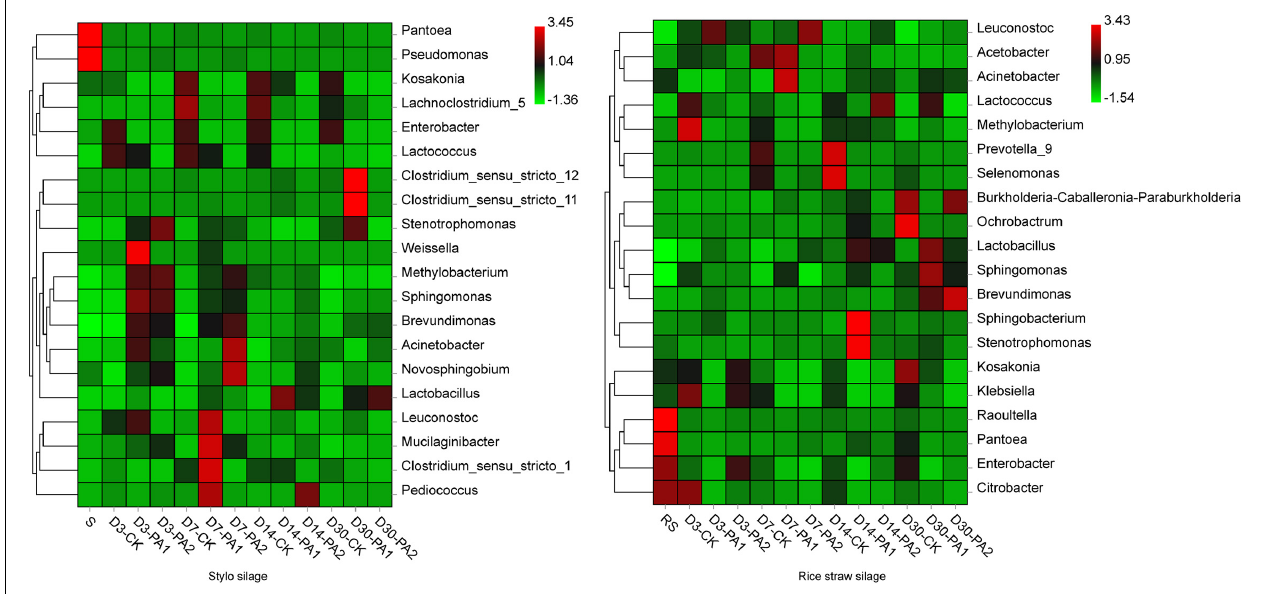
FIGURE 3 | Heatmap of bacterial communities at the genus level in stylo and rice straw before and after ensiling for 3, 7, 14, and 30 days with or without 1% or 2% pyroligneous acid.